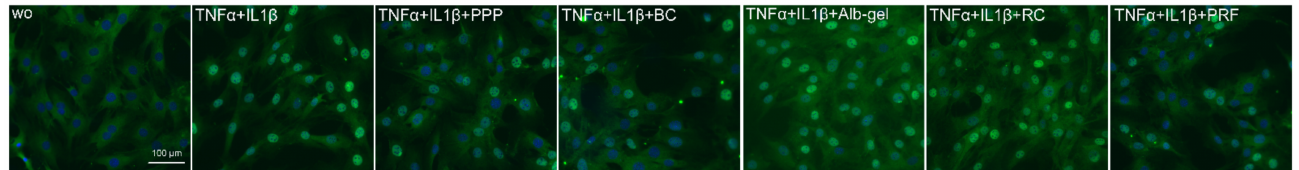
Figure 7. PPP, BC, and PRF attenuated the translocation of NF- κ B from the cytoplasm into the nucleus. ST2 cells were exposed to TNF α and IL1 β with or without PPP, BC, Alb-gel, RC, and PRF. Immunofluorescence analysis of intracellular translocation of NF- κ B p65 into the nucleus. Blue nuclei indicate the unstained cells and green nuclei are positive stained cells. WO means without and represents unstimulated cells.